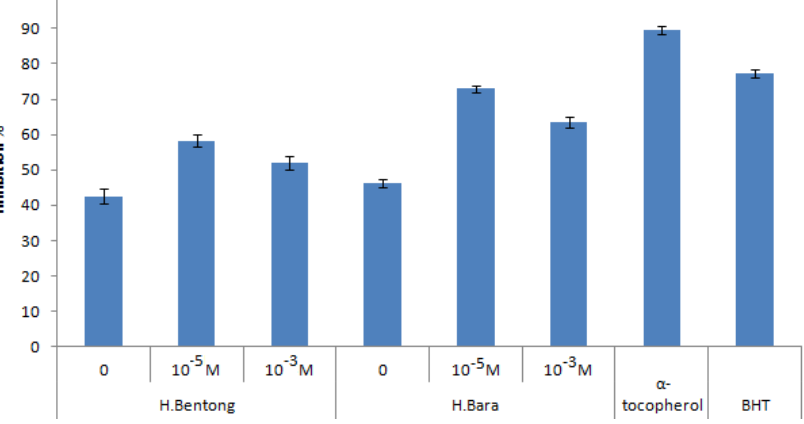
Figure 3. 1,1-Diphenyl-2-picrylhydrazyl (DPPH) scavenging activities of two varieties of